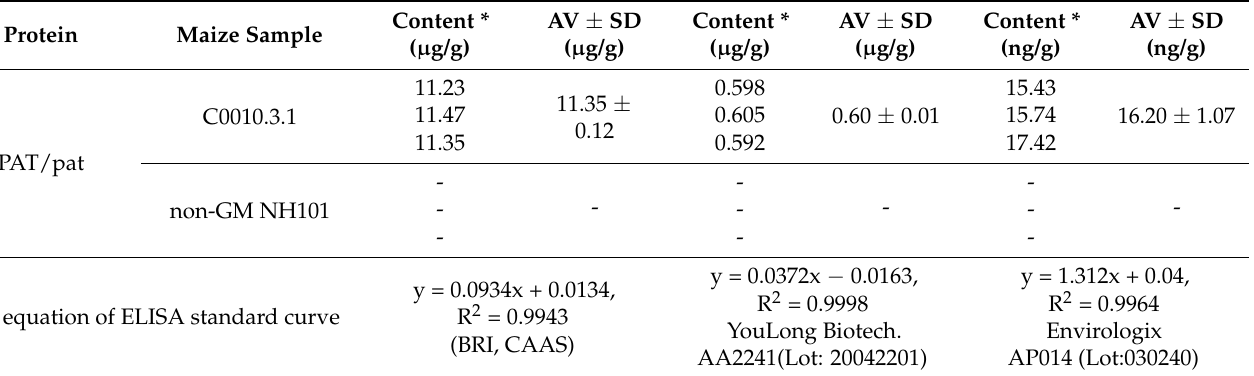
Table 6. PAT/pat content in the maize